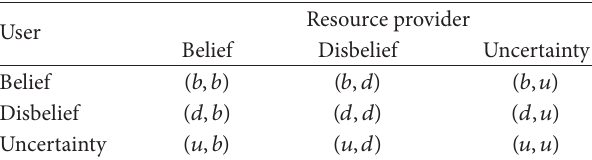
Table 1: Table form of (1).